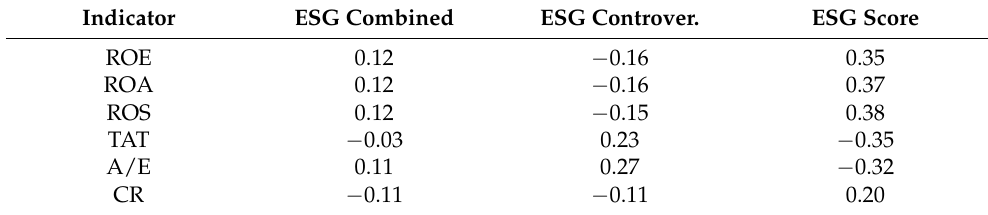
Table 7. Correlations between values of indicators taken into account in research in the case of the enterprise Polski Koncern Naftowy Orlen S.A. (period of 2010–2019). Indicator ESG Combined ESG Controver. ESG Score ROE 0.12 − 0.16 0.35 ROA 0.12 − 0.16 0.37 ROS 0.12 − 0.15 0.38 TAT − 0.03 0.23 − 0.35 A/E 0.11 0.27 − 0.32 CR − 0.11 − 0.11